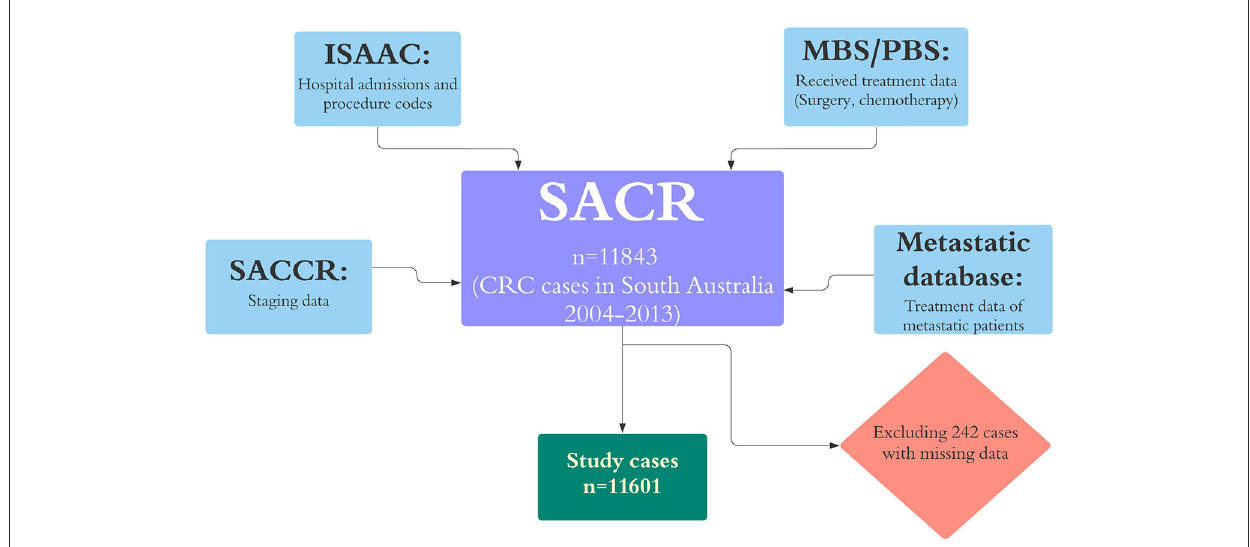
FIGURE1 Datasets that were linked to SACR for this study and excluded cases. ISAAC, the Integrated South Australian Activity Collection; MBS, the Medicare Benefits Schedule; PBS, the Pharmaceutical Benefits Scheme; RAH, the Royal Adelaide Hospital; ARC, the Adelaide Radiotherapy Centre; and SACR, the South Australian Cancer